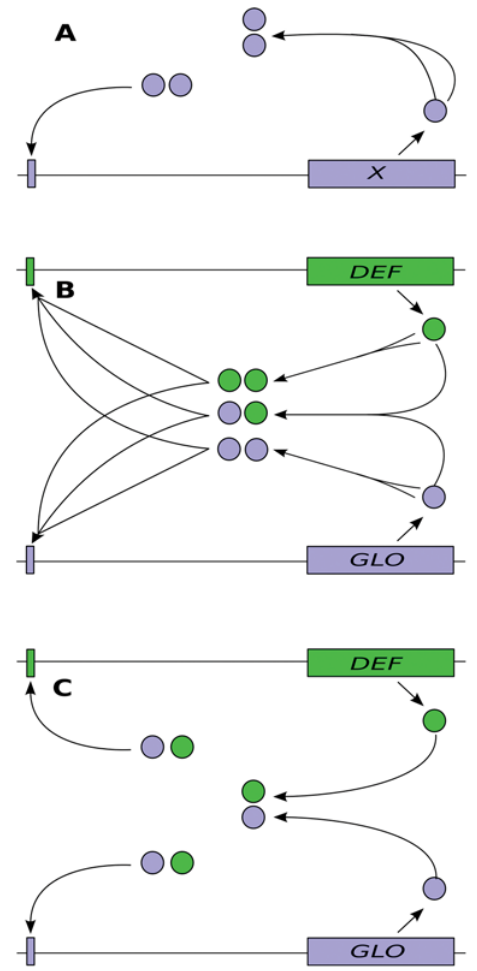
Figure 1. The three types of regulatory mechanisms that are investigated. ‘‘DEF’’ and ‘‘GLO’’ denote DEF-like and GLO-like genes. Large boxes represent the coding regions of genes (neglecting intron- exon structure), small boxes symbolize cis -regulatory elements (CArG- boxes). (A) Ancestral state. A single gene X is positively regulated by a dimer of its gene product. (B) Intermediate state. After gene duplication, three types of protein dimers can be formed, since both homo- and heterodimerization are possible. All three dimers regulate both genes. (C) Final state. After having lost the homodimerization ability, the remaining heterodimer regulates both